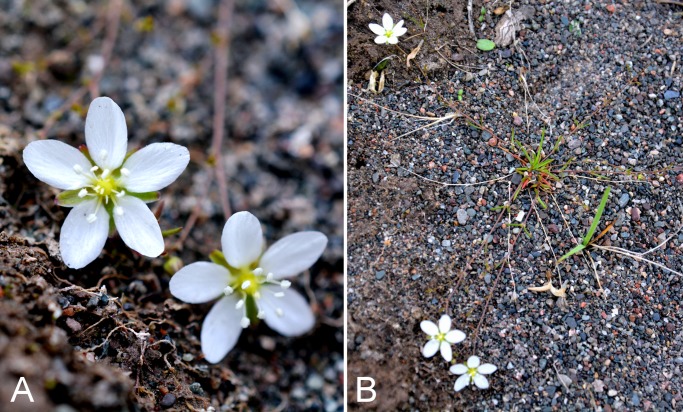
Sagina nodosa subsp. borealis.(A) Inflorescence, Saarela et al. 4413. (B) Habit, Saarela et al. 4413. Photographs by P. C. Sokoloff.